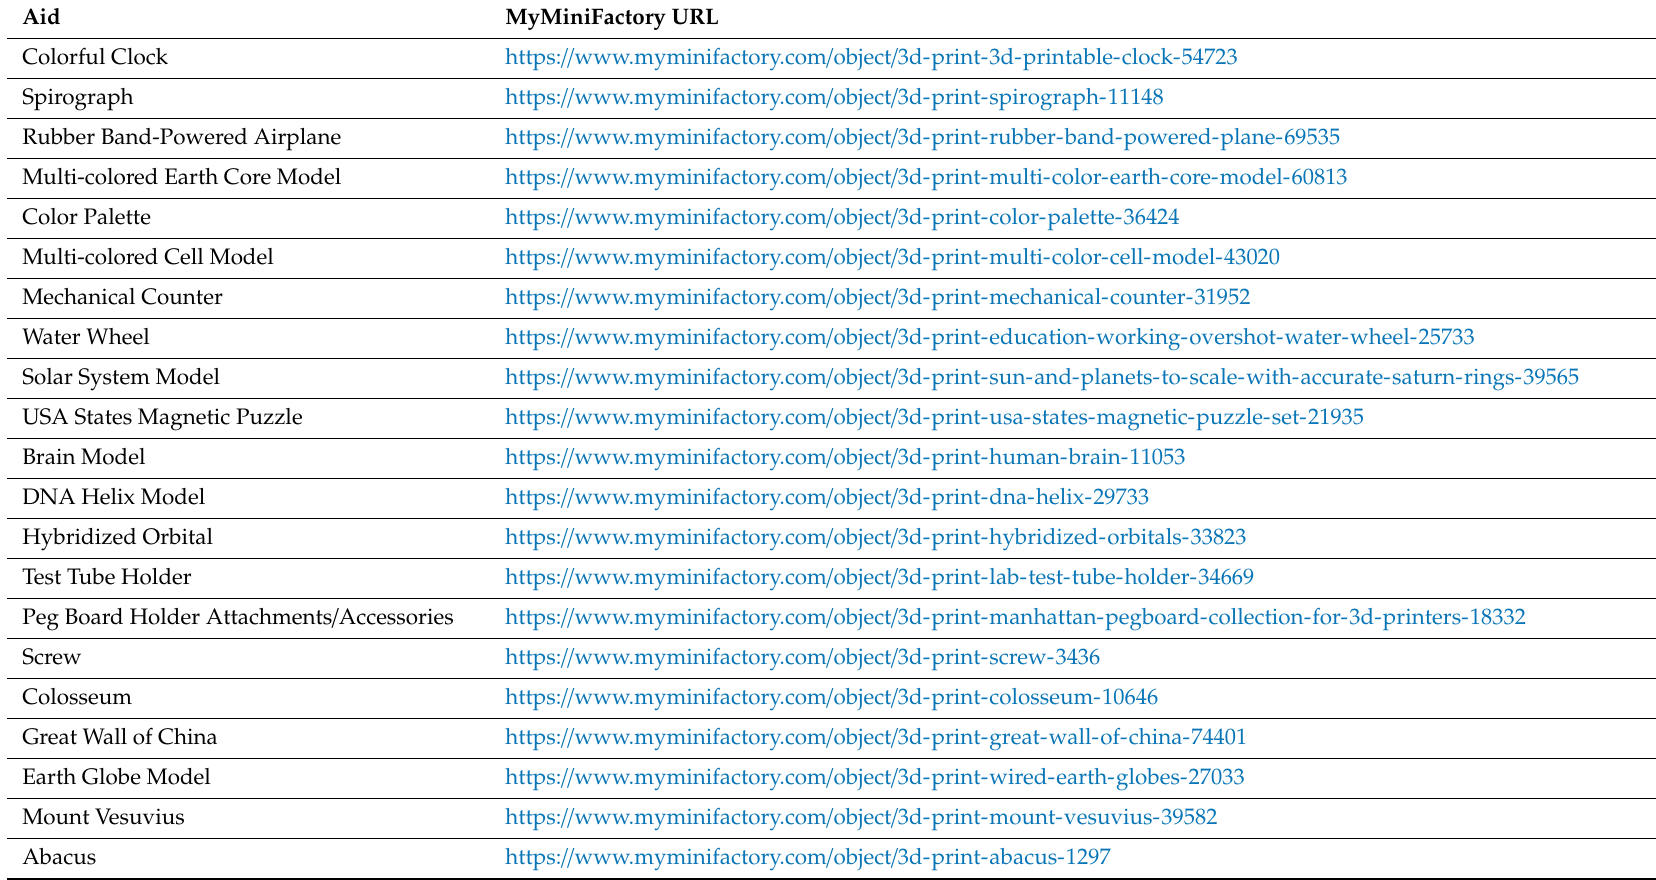
Table A1. Source file uniform resource locators (URLs) at